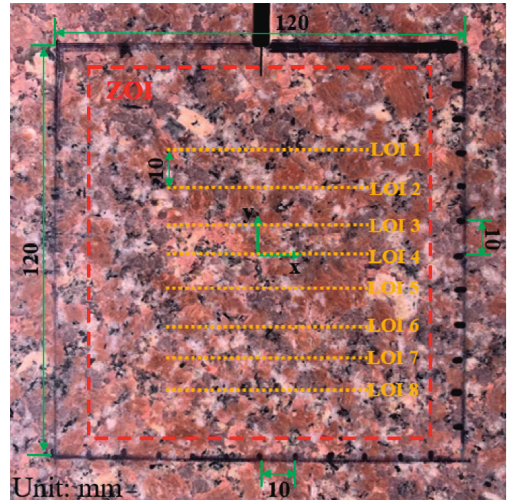
Figure 5: Zone of interest (ZOI) and line of interest (LOI).